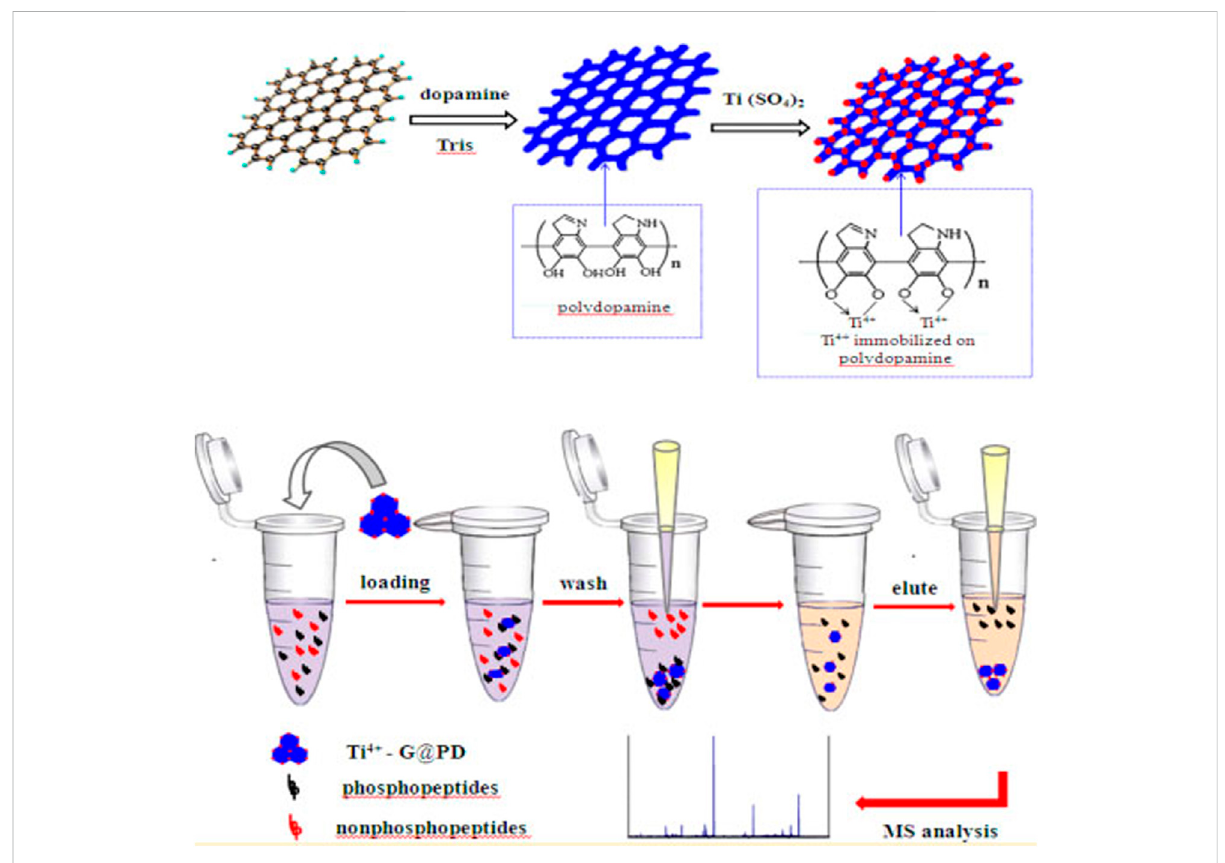
The Ti4+-G@PD with the above unique properties was anticipated to have excellent performance for the selective enrichment of phosphopeptides, which would be highly bene fi cial for mass spectrometric analysis. Reproduced from ref 45. Copyright 2003 American Chemical